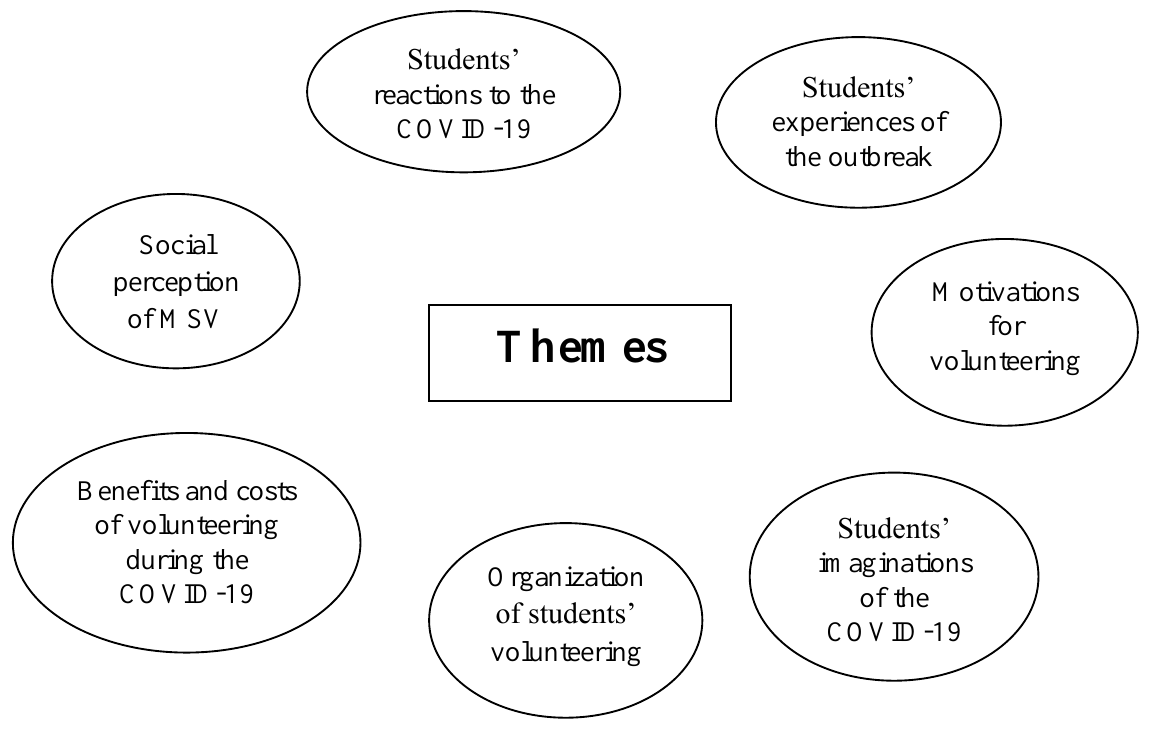
Figure 1. Themes Emerging from Qualitative